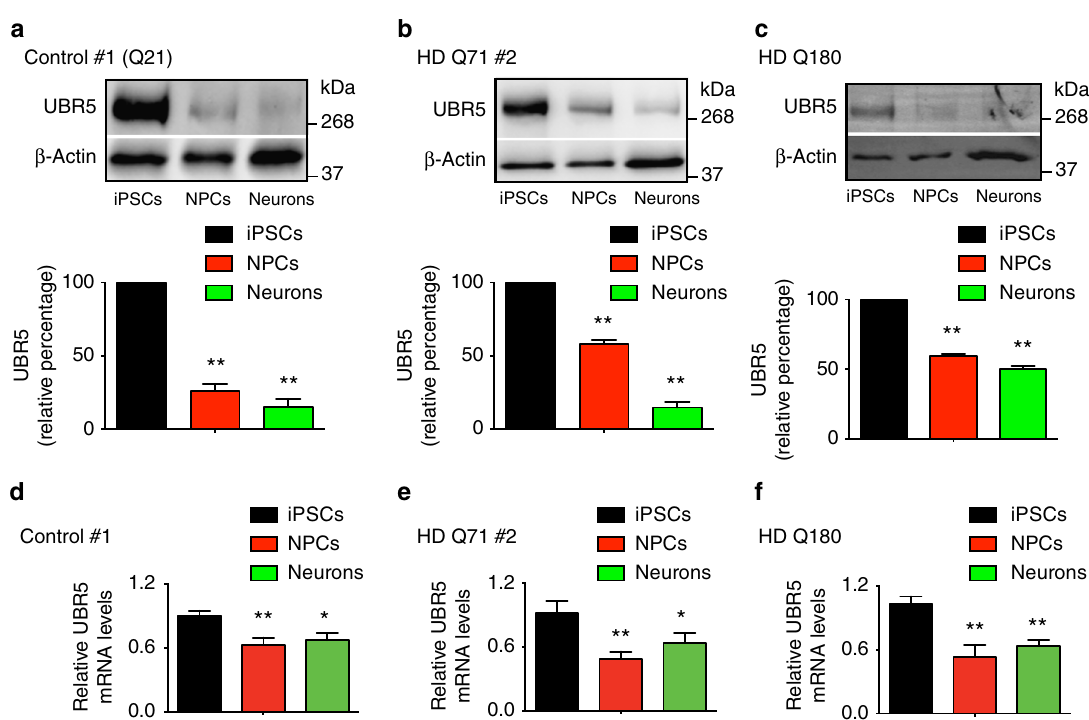
Fig. 3 The levels of UBR5 decrease during differentiation of iPSCs. a – c Western blot of UBR5 levels in control #1 ( a ), HD Q71 #2 ( b ) and HD Q180 ( c ) iPSC lines compared with their neural progenitor cell (NPC) and striatal neuron counterparts. The graphs represent the UBR5 relative percentage values to the respective iPSCs corrected for β -actin loading control (mean ± s.e.m. of three independent experiments for each cell line). d – f Quantitative PCR (qPCR) analysis of UBR5 mRNA levels in control #1 ( d ), HD Q71 #2 ( e ) and HD Q180 ( f ) iPSC lines compared with their differentiated counterparts. Graphs ( UBR5 relative expression to iPSCs) represent the mean ± s.e.m. of three independent experiments for each line. * P < 0.05, ** P <